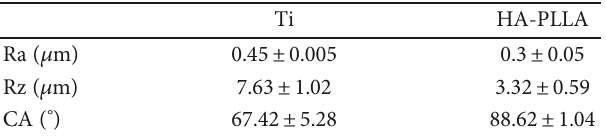
Table 2: Transmittance and re fl ectance of Ti and HA-PLLA